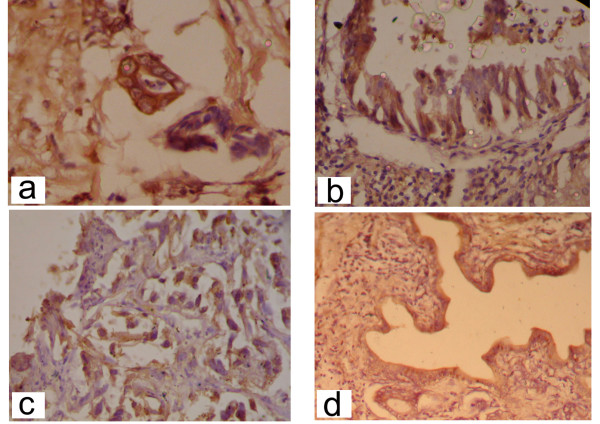
Photomicrograph showing c-erbB-2 staining. (Fig 2b and d) patchy and membranous positivity in well differentiated carcinoma; (2a) in moderately differentiated carcinoma; (2c) cytoplasmic and membranous in poorly differentiated carcinoma